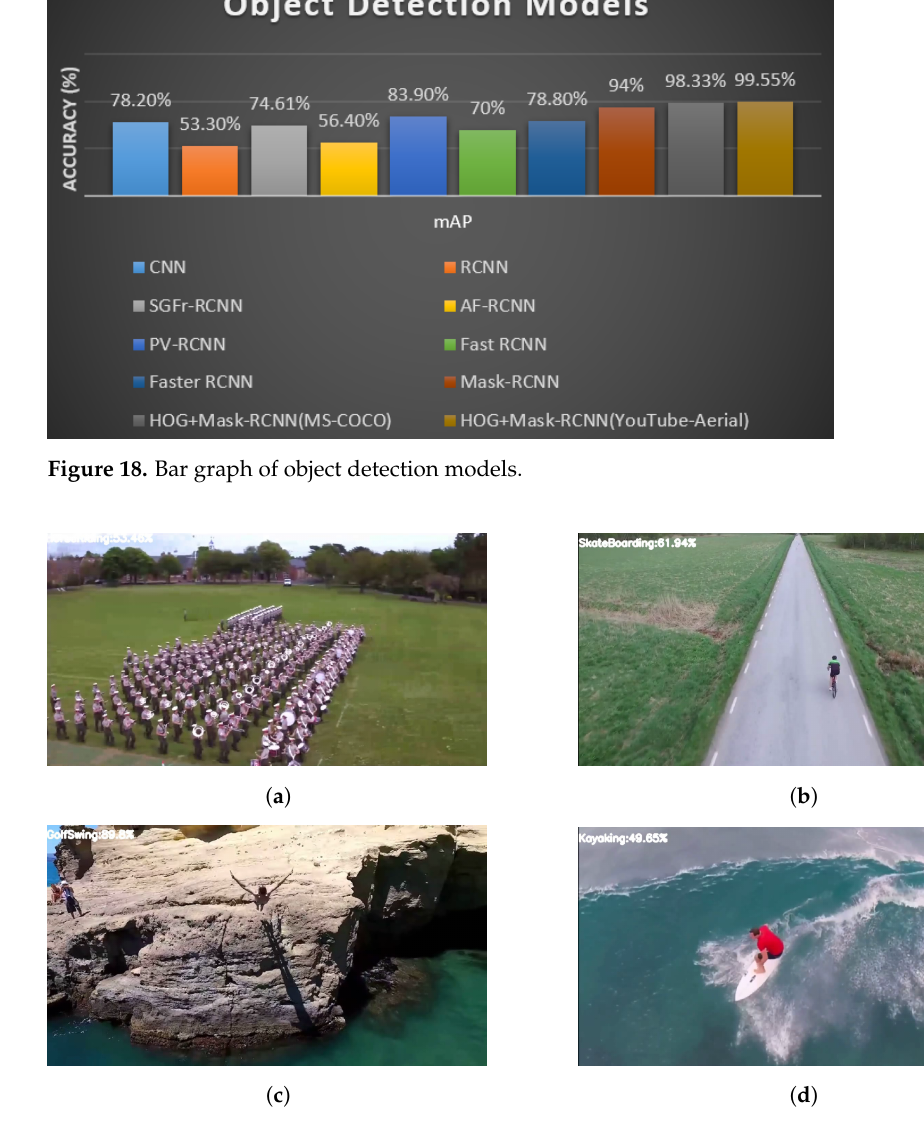
Figure 19. Some of the unclassified results from the other state-of-the-art models. ( a ) BandMarching unclassified as HorseRiding. ( b ) Biking unclassified as SkateBoarding. ( c ) CliffDiving unclassified as GolfSwing. ( d ) Surfing unclassified as